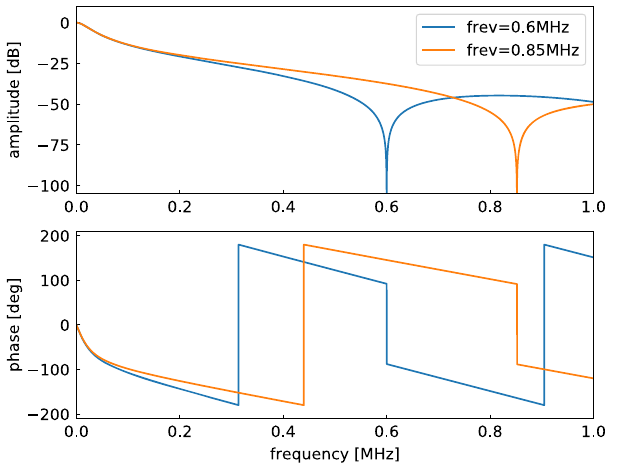
FIG. 13. Amplitude and phase responses of the hybrid filter for ¼ 600 and 850 kHz. Avalue of k ¼ 10 is chosen in the leaky f rev integrator.